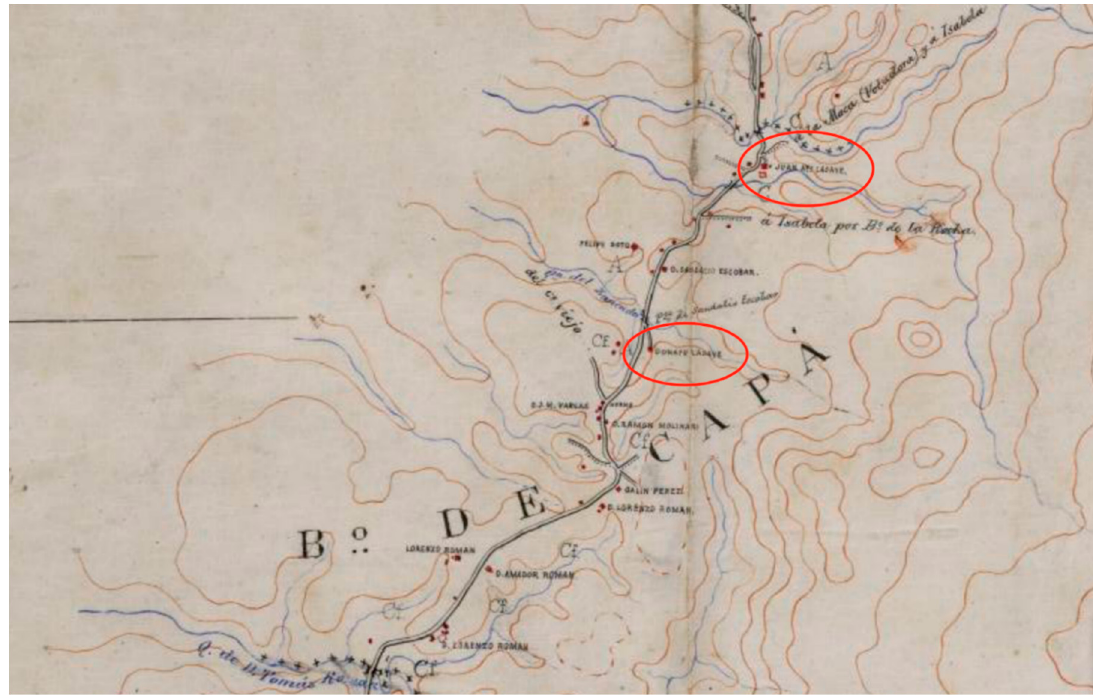
Figure 7. Map of Barrio Capa, Moca: in this 1901 military map, the oval annotations indicate locations of haciendas for 2 Lasalle descendants, Juan Bta. Lassalle and Donato Lasalle, a century after their ancestor originally established a coffee plantation there. Num. 22 Mapa Militar de la Isla, Comision topographico 1889, Itinerario: San Sebastian a Moca, 1901. ADNPR.net .